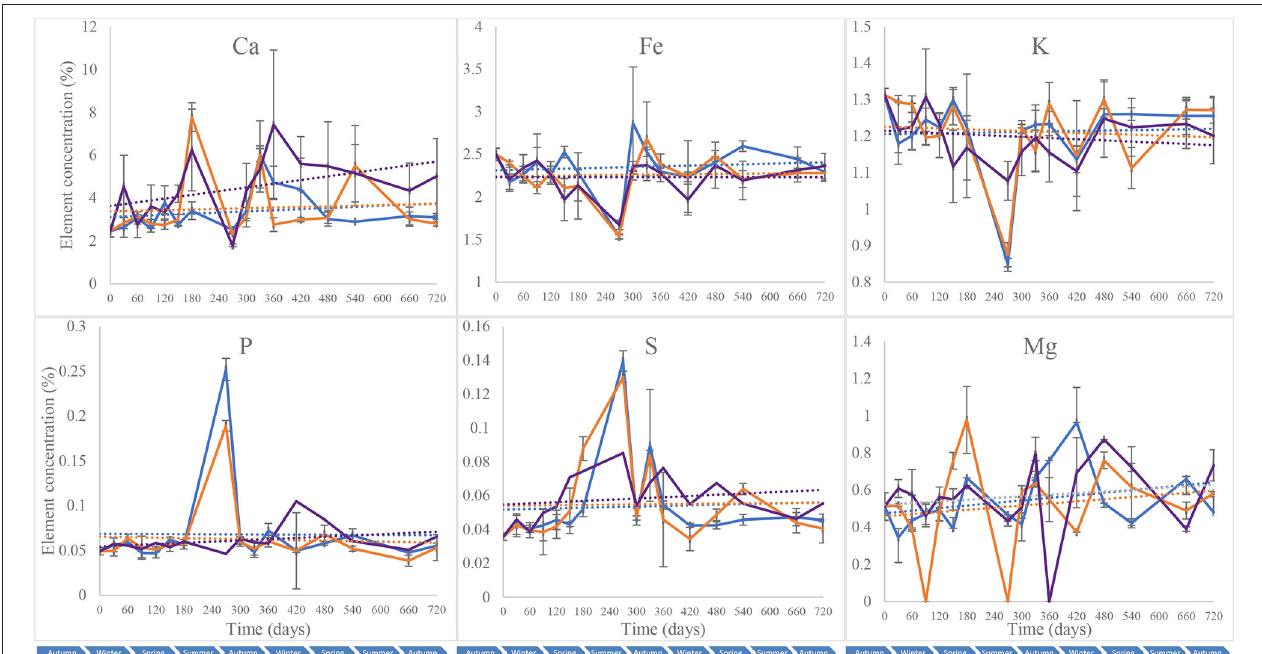
FIGURE 8 | Average ( n = 3) soil composition in calcium (Ca), iron (Fe), potassium (K), phosphorus (P), sulphur (S), and magnesium (Mg) for control ( • ), leaf litter ( • ), and S. Scrofa domesticus ( • ) treatments. Each data point is the mean of triplicate samples. Error bars are